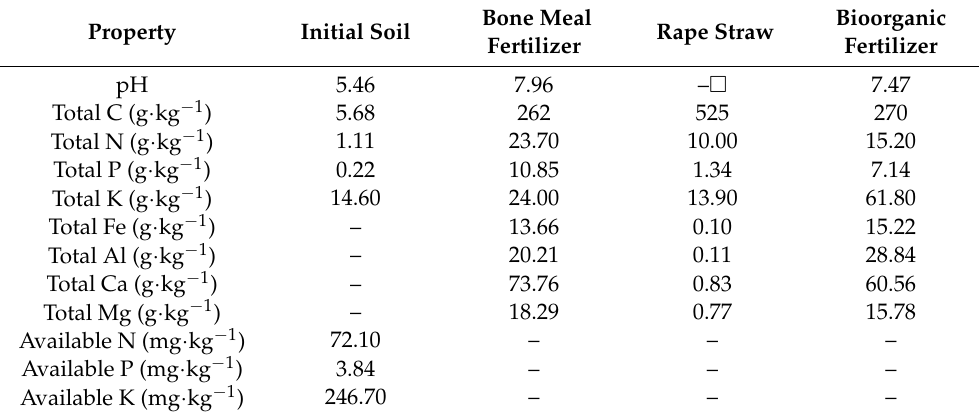
Table 1. Basic physicochemical properties of initial soil and three organic fertilizers.